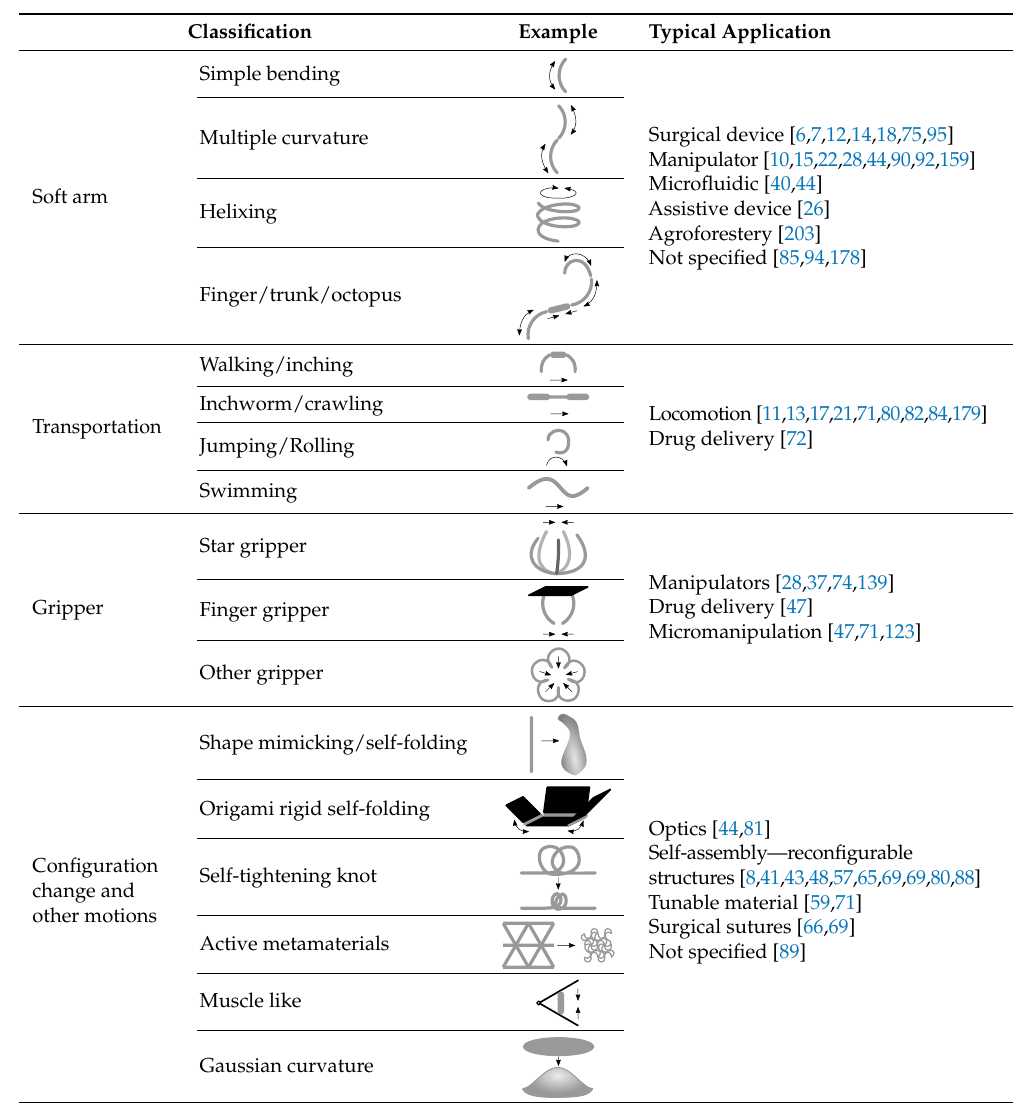
Table 4. Complex motions classification and their typical applications: black indicates a rigid material, and grey indicates the